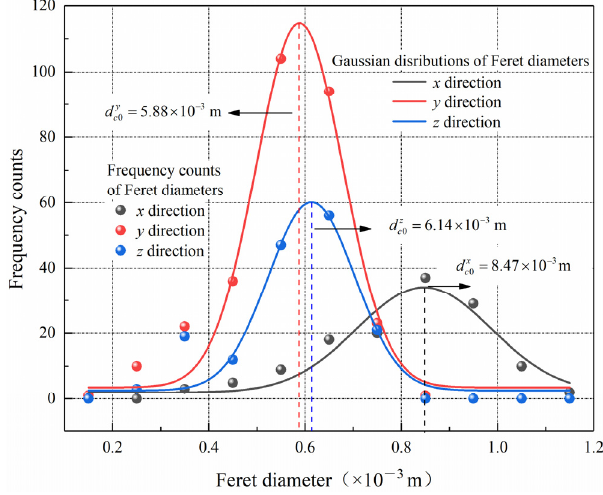
Figure 4. Distributions of measured cell sizes in different directions